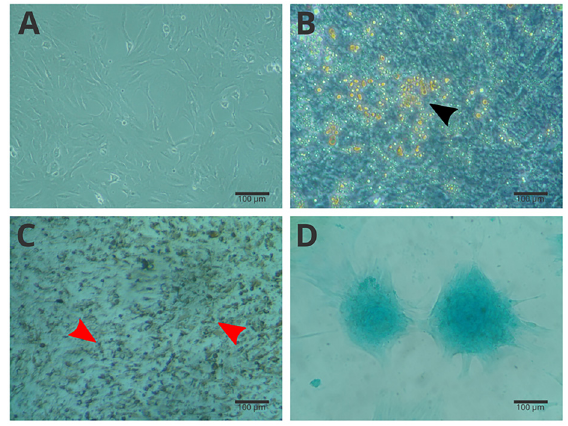
Figure 2. Human bone marrow mesenchymal stem cells immortalized by the expression of telomerase (hBMSC-TERT). Passage fi ve plastic-adherent cells cultured in a -MEM supple- mented with 10% fetal bovine serum ( A ) and differentiated into adipogenic lineages identi fi ed by Sudan II (0.2%) ( B ), osteogenic lineages identi fi ed by von Kossa technique ( C ), and chondrogenic lineages identi fi ed by Alcian blue (1%) ( D ). Scale bar 100 m